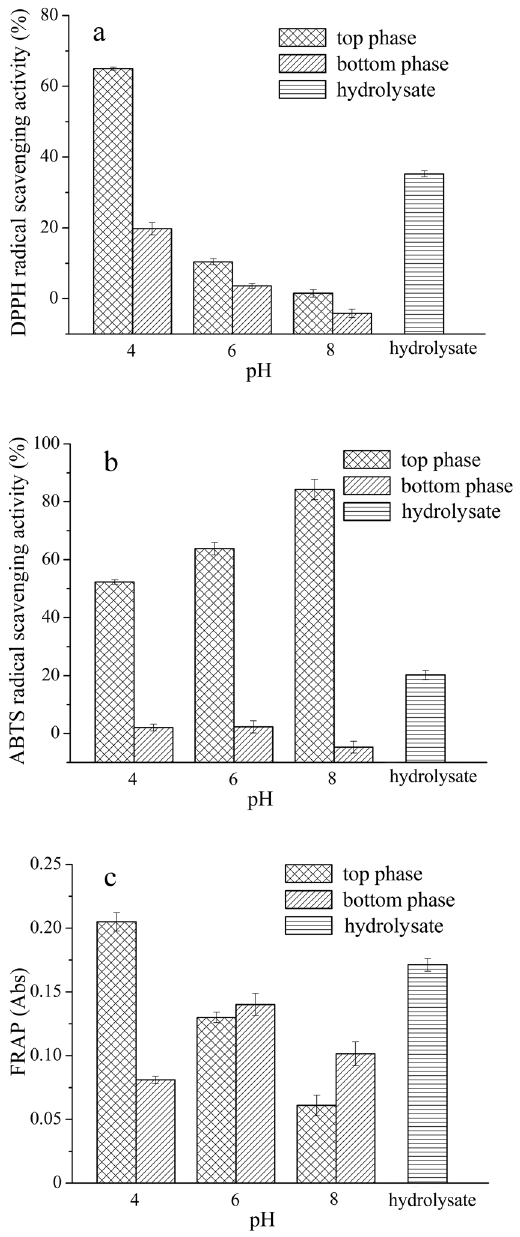
Figure 1. Effect of pH on the separation of antioxidant peptides. ( a ) DPPH radical scavenging activity; ( b ) ABTS radical scavenging activity; ( c ) ferric reducing antioxidant power